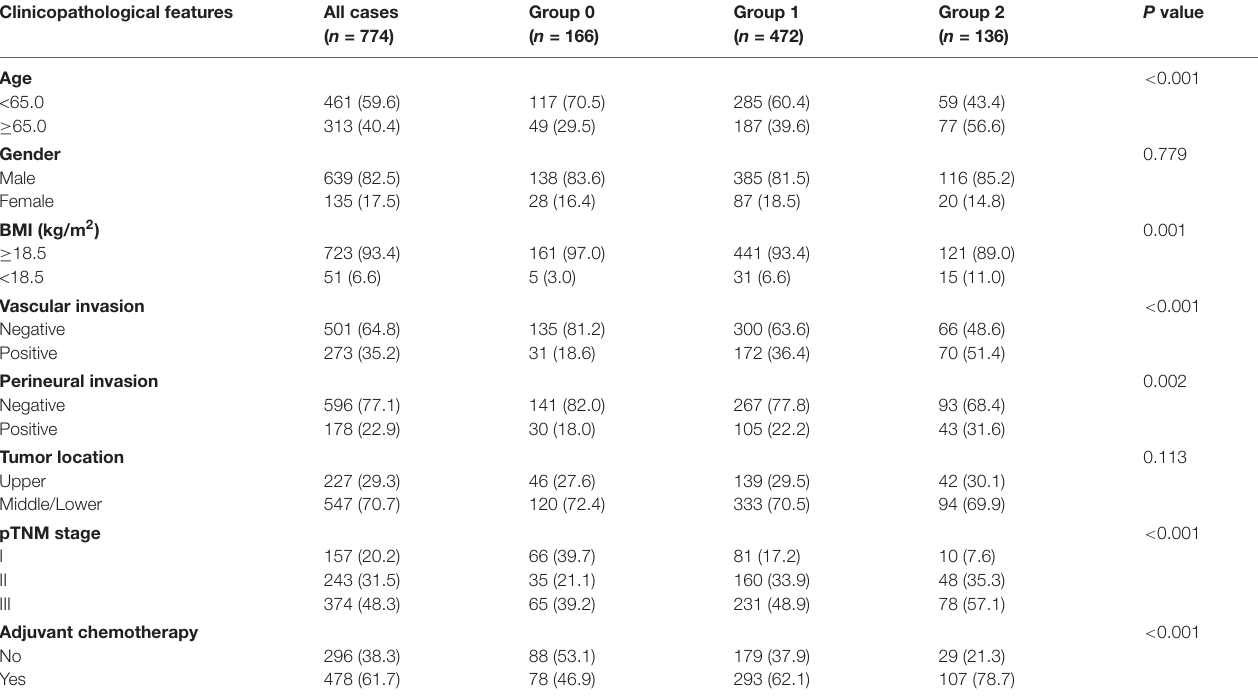
TABLE 1 | Association of Peking prognostic score and clinicopathological characteristics in patients with gastric cancer (discovery cohort). Clinicopathological